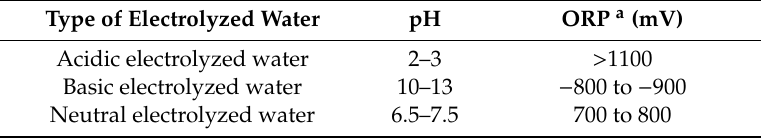
Table 1. Properties of different types of electrolyzed water.